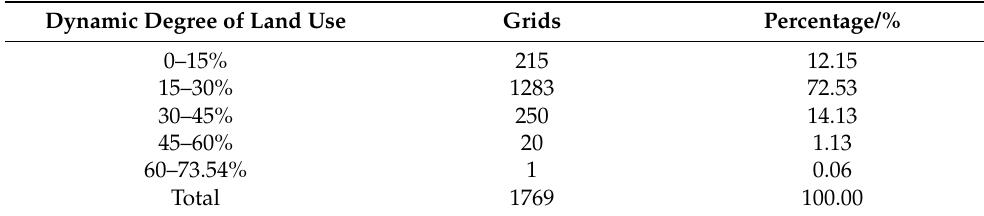
Table 3. Dynamic degree of land use in Xintai from 2009 to